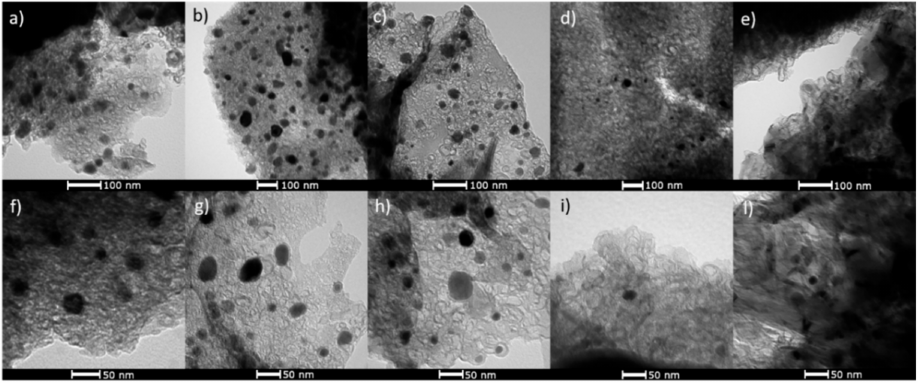
Figure 1. TEM images of ( a , f ) Fe-N-C1; ( b , g ) Fe-N-C2; ( c , h ) Fe-N-C3; ( d , i ) Fe-N-C4 and ( e , l ) Fe-N-C5. Table 2. Physical and chemical properties of some chitosan-based Fe-N-Cn electrocatalysts. Supports N 2 Ads/Desorption